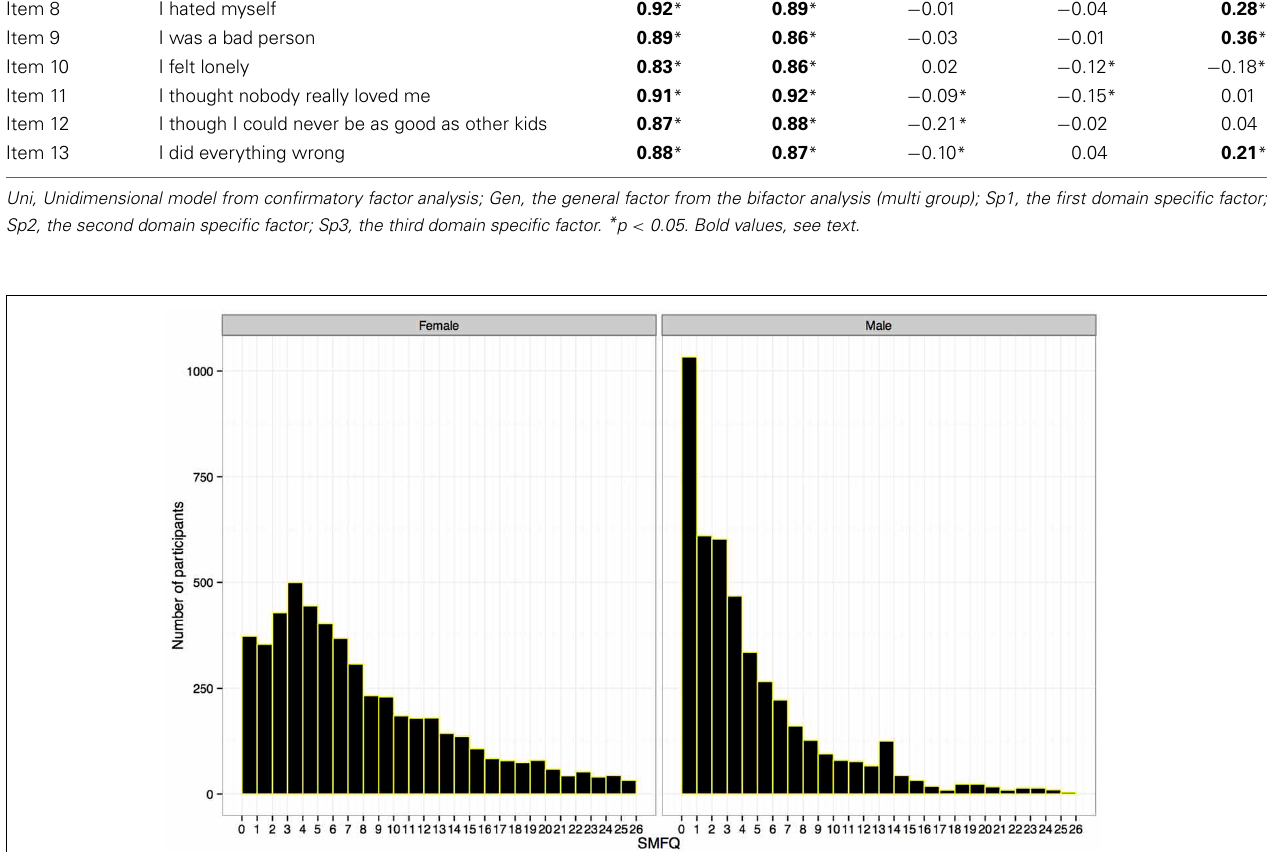
(latent mean (cid:2) 0.68 variance girls = 0.653, boys = 0.943) when the fully constrained model was